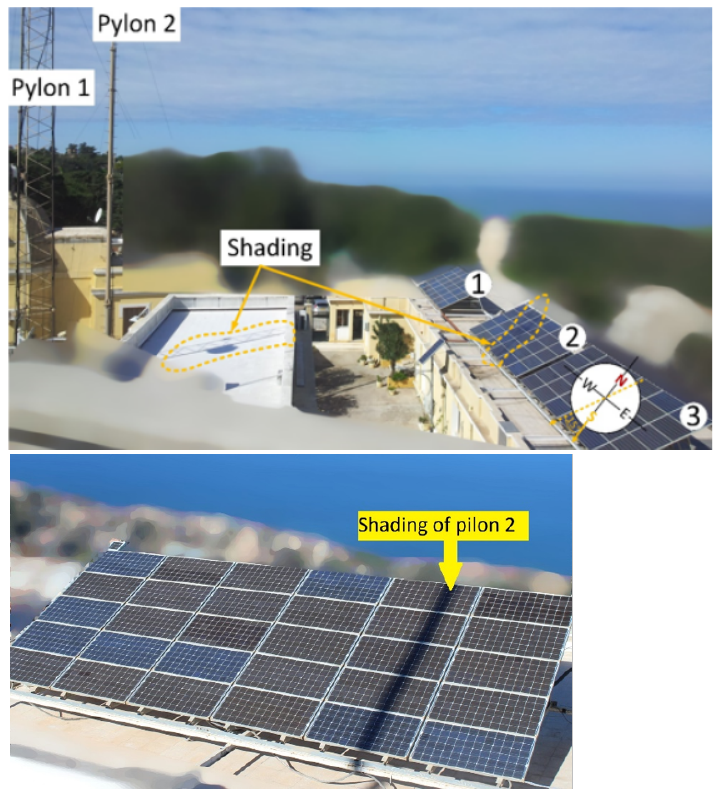
Figure 16. ( Top ) PV array with shaded modules due to two communication pylons installed in front of this PV array. ( Bottom ) Shading of pylon 2 on PV sub-array